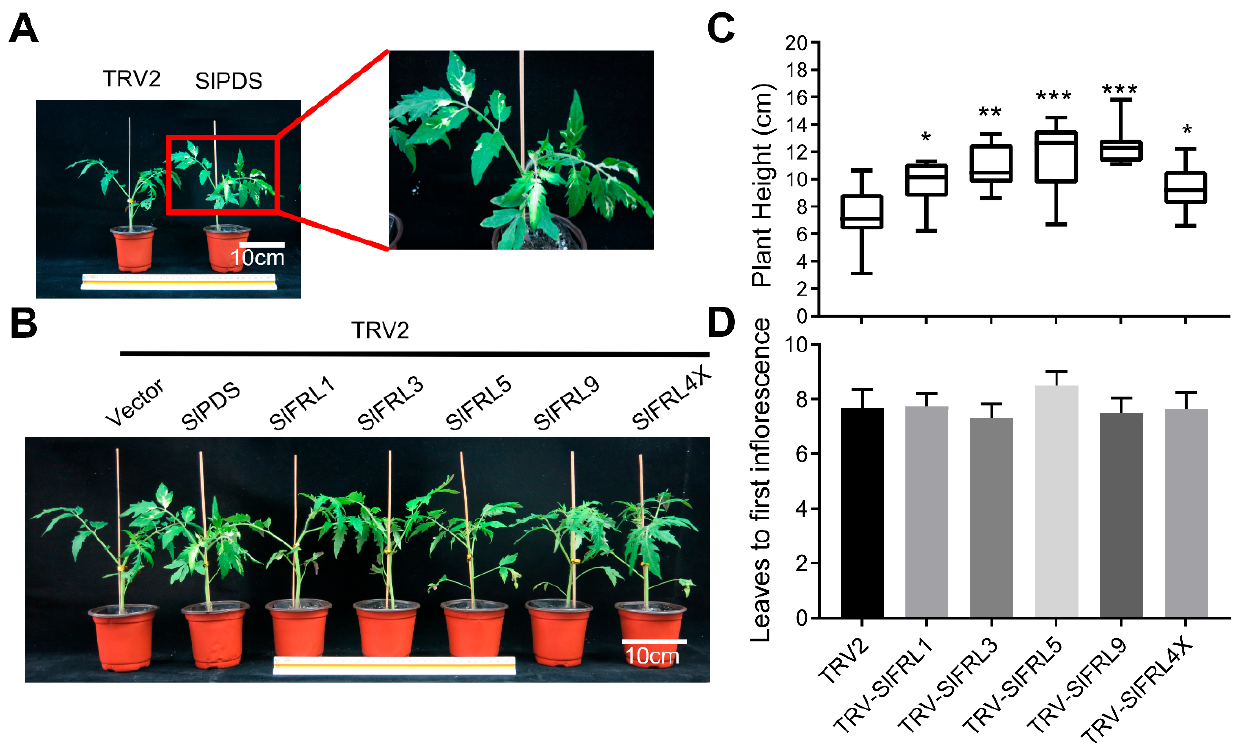
Figure 9. Transient silencing of SlFRLs promotes plant height in tomato. ( A ) was the phenotype of TRV2- SlPDS plants and their albino leaves, ( B ) was the phenotype of transient transformation materials at 4 weeks, ( C , D ) was the plant height at 4 weeks of each material in ( B ) and the number of true leaves under the first panicle. TRV- SlFRL4X is a mixture of TRV- SlFRL1 , TRV- SlFRL3 , TRV- SlFRL5 and TRV- SlFRL9 . n ≥ 8. In the figure one star (*) stand for 5% level of significance while 2 stars (**) for 1% and 3 stars (***) for 0.1% level of significance.